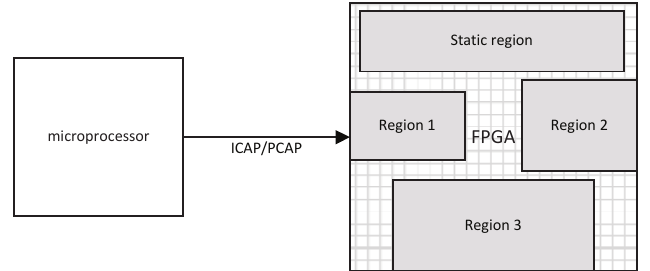
Figure 1. An example dynamic partial reconfigurable (DPR) SoC platform. ICAP, internal configuration access port; PCAP, processor configuration access port.